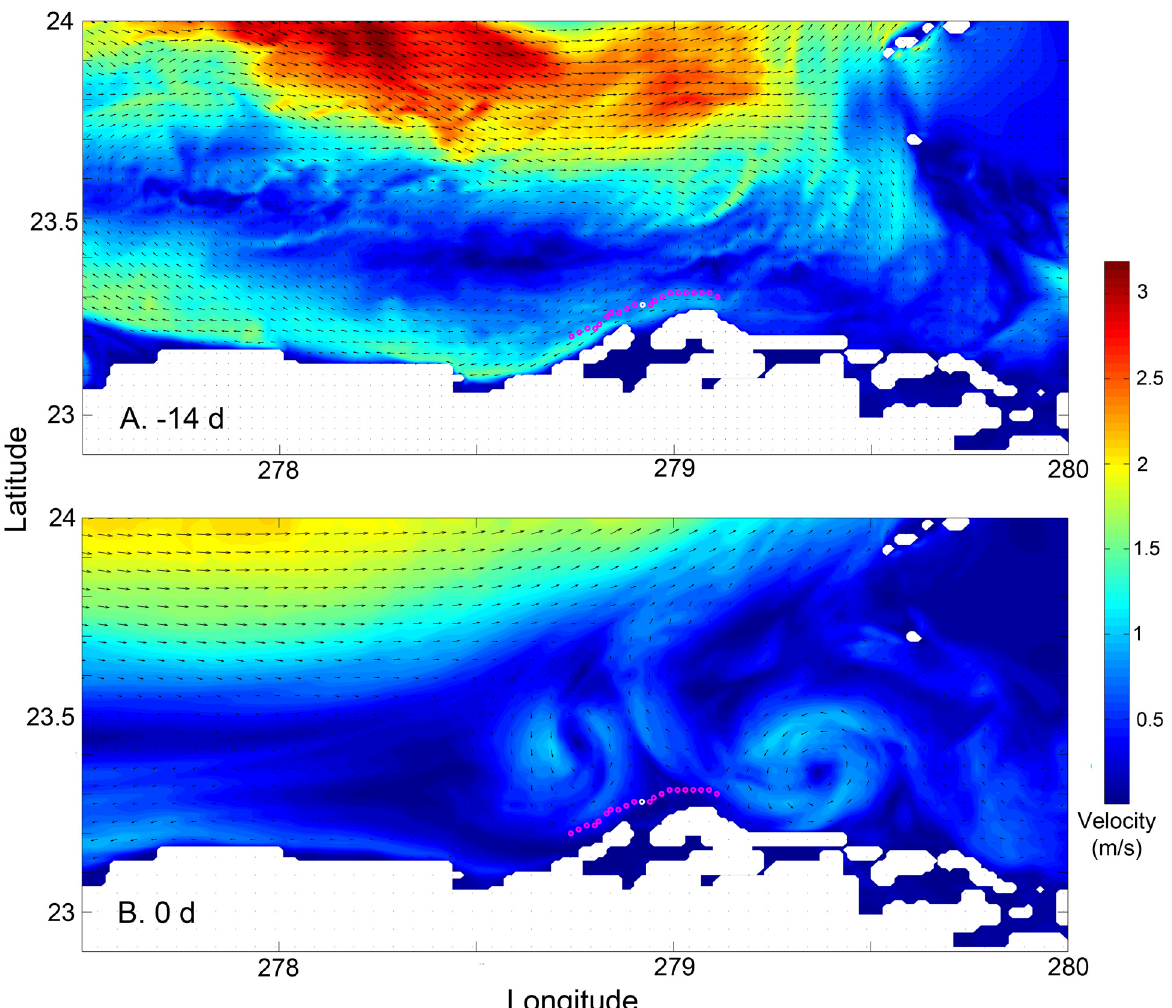
Fig 4. Oceanographic currents adjacent to Punta Hicacos (a) 14 days before the center of the spawning window and (b) on the central day in the spawning window. Dots along the coast indicate larval release locations; the central, white dot is a known spawning location and the adjacent red dots are the other release locations. The data for this plot is from 2004; similar changes are seen in other